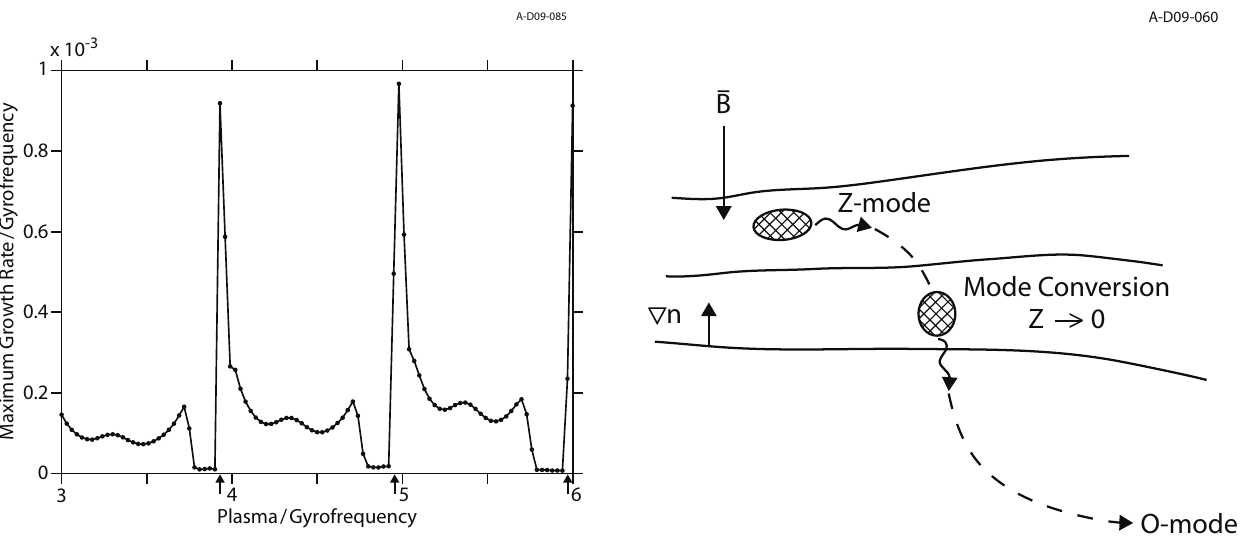
Fig. 10. A cartoon showing how Z-mode waves generated at large wave normal angles can refract to small wave normal angles in a density gradient along the magnetic field as is the case near the high latitude boundaries of the Enceladus torus. These Z-mode waves will be expected to mode convert to O-mode (NB emission) and then refract to propagate perpendicular to the density